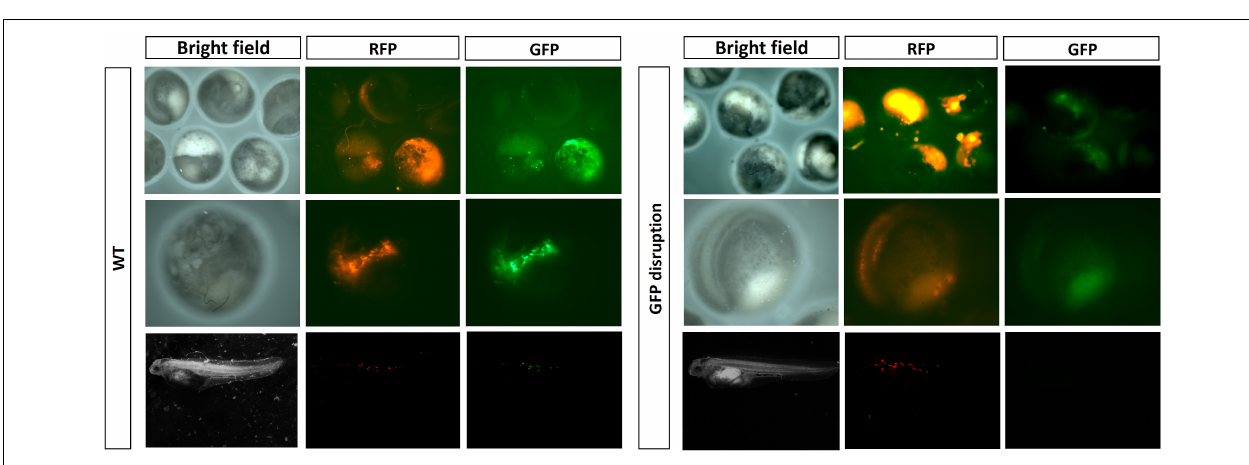
FIGURE 5 | Detection of EGFP disruption by